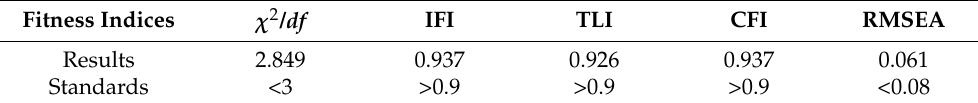
Table 3. Results of CFA for the questionnaire.